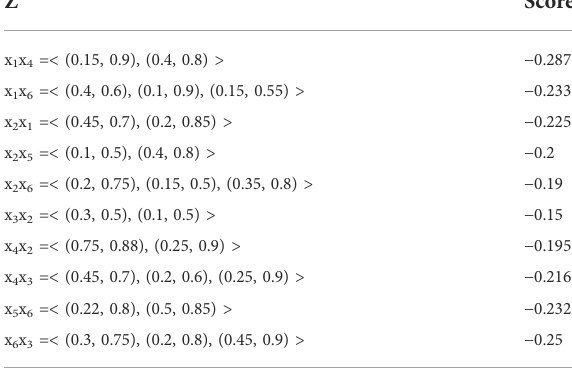
TABLE 5 Value of the in fl uence of one person on another person. Z